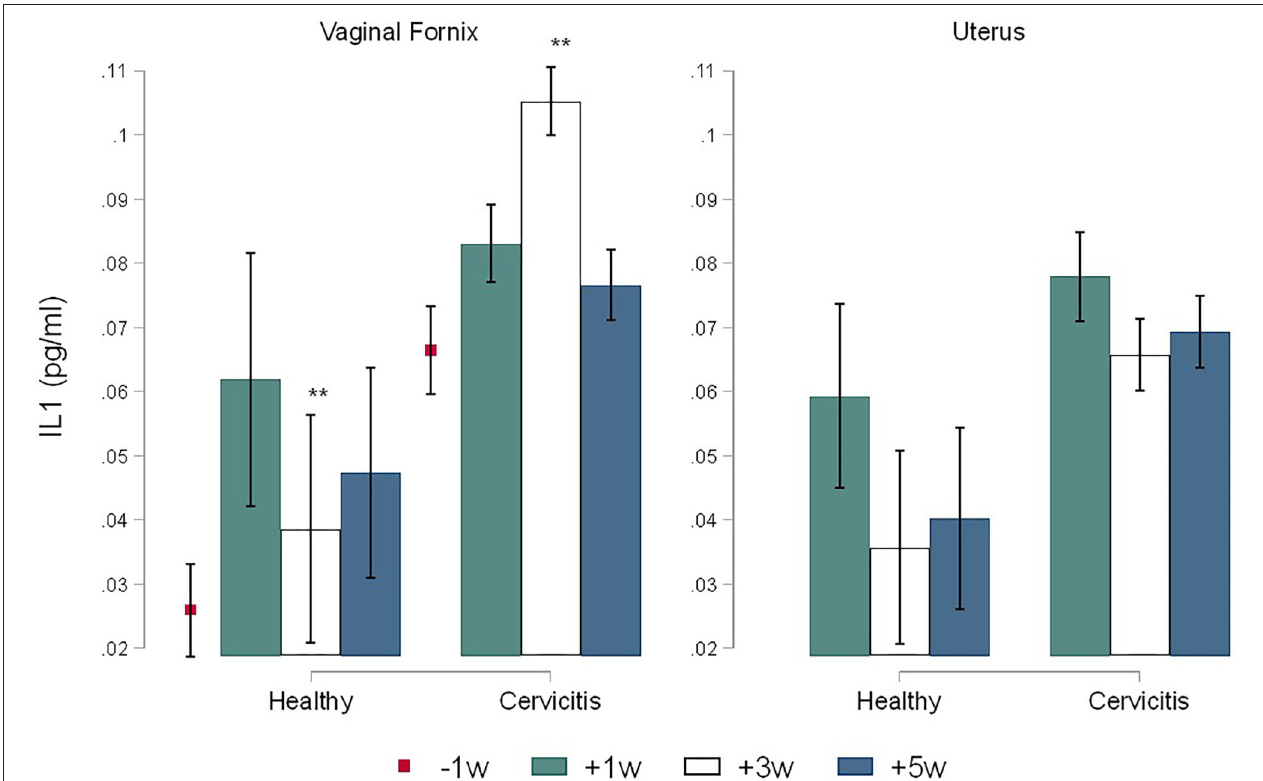
FIGURE 3 | Time-course variations (Mean ± SEM) in pre and post-partum concentrations of IL1 IL8 in the vaginal fornix and uterine mucus of cows ( n = 26) defined as clinical cervicitis cows ( n = 19) and healthy cows ( n = 7) from three dairy herds in Quebec in 2016. Time-course variations (weeks − 1w + 1w + 3w + 5w) of Interleukin 1 α (pg/ml) concentrations (Mean ± SEM). An asterisk indicates a significant difference at p ≤ 0.05 (*) or p ≤ 0.01 (**) for the Mann-Whitney Test (Ha: clinical cervicitis cows 6= healthy